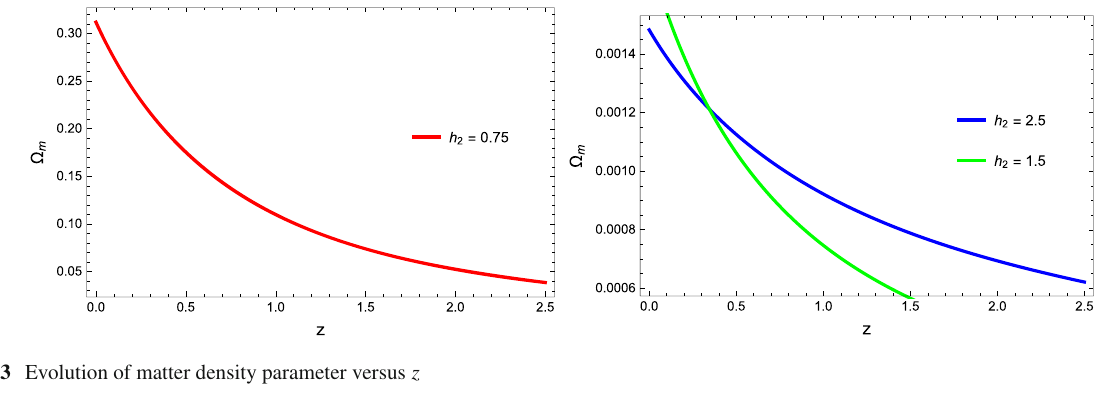
Fig. 13 Evolution of matter density parameter versus z